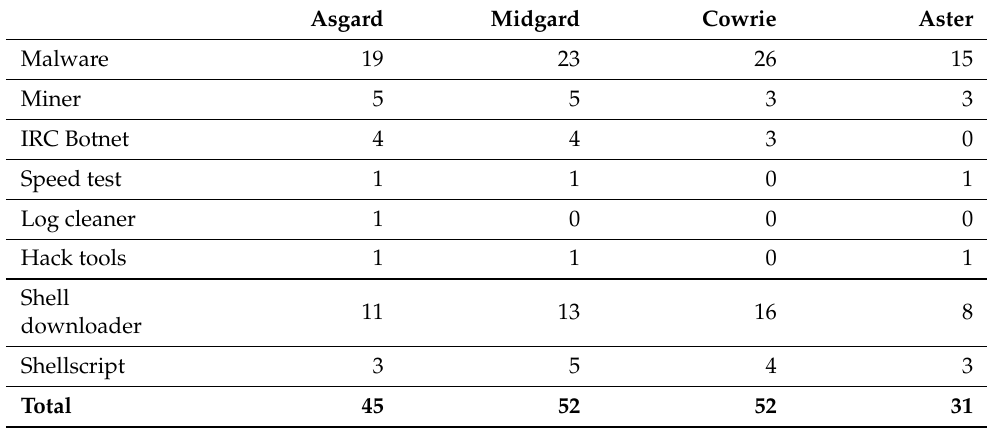
Table 3. Different types of files that were downloaded by each honeypot. Asgard Midgard Cowrie Aster